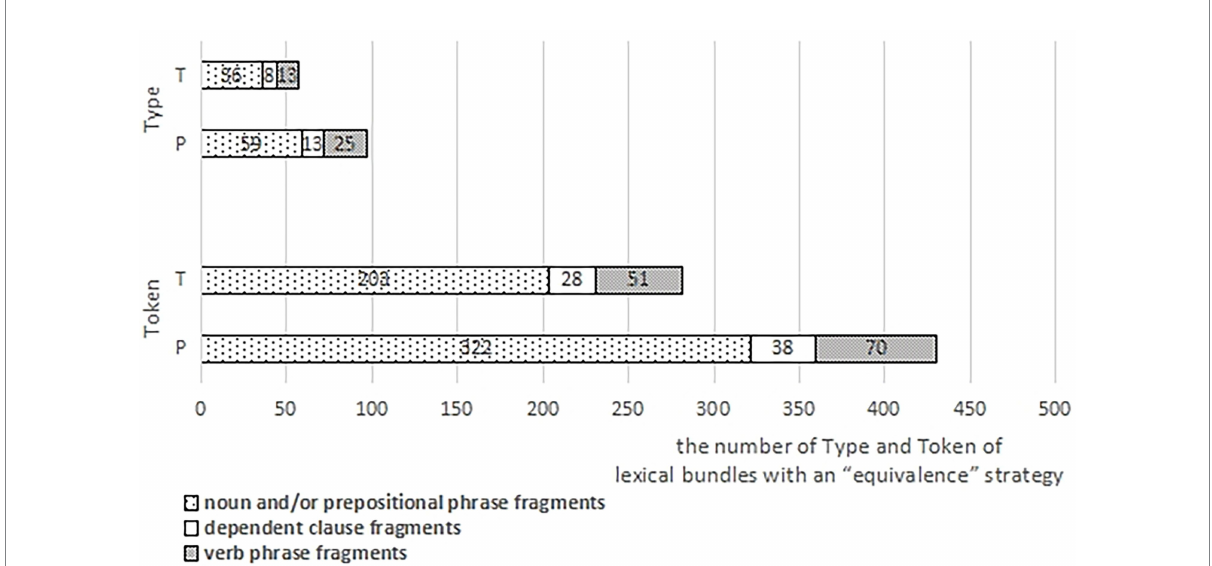
FIGURE 1 The relationship between the strategy (Equivalence) and structures (Three Fragments) of lexical bundles from the two groups.